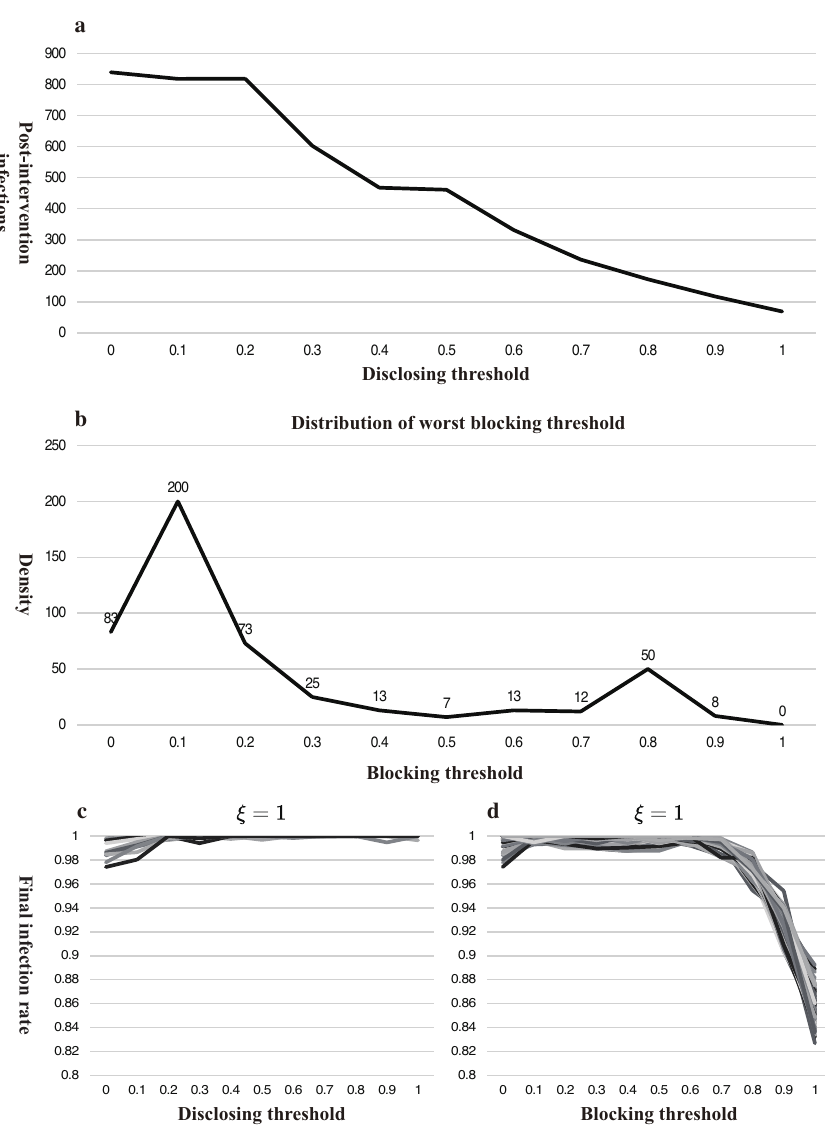
Figure 6. Simulation results for non-neutral governments and low-credible governments. ( a ) portrays the unaccountable governments based on the settings in Figure 4a, the vertical axis is the number of newly infected people after government intervention; ( b ) the distribution of worst blocking threshold (highest infections) based on the settings of Figure 5 portrays the risk-averse government; ( c , d ) describe the low-credible governments by reassigning for government’s credibility 10% while keeping other variables